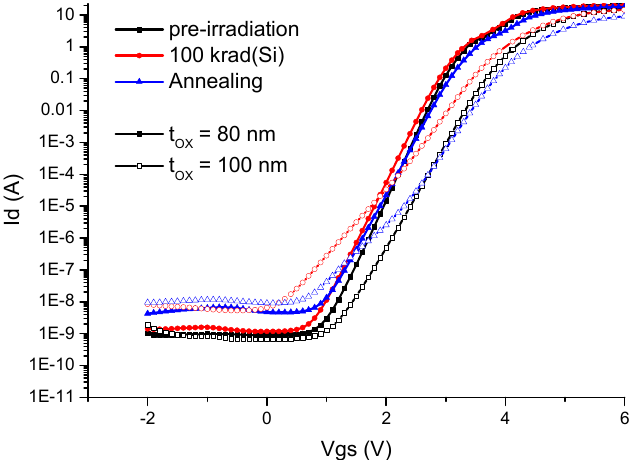
Figure 5. Subthreshold characteristics of power devices with 80 nm and 100 nm gate oxides pre- and post-irradiation and post-annealing.